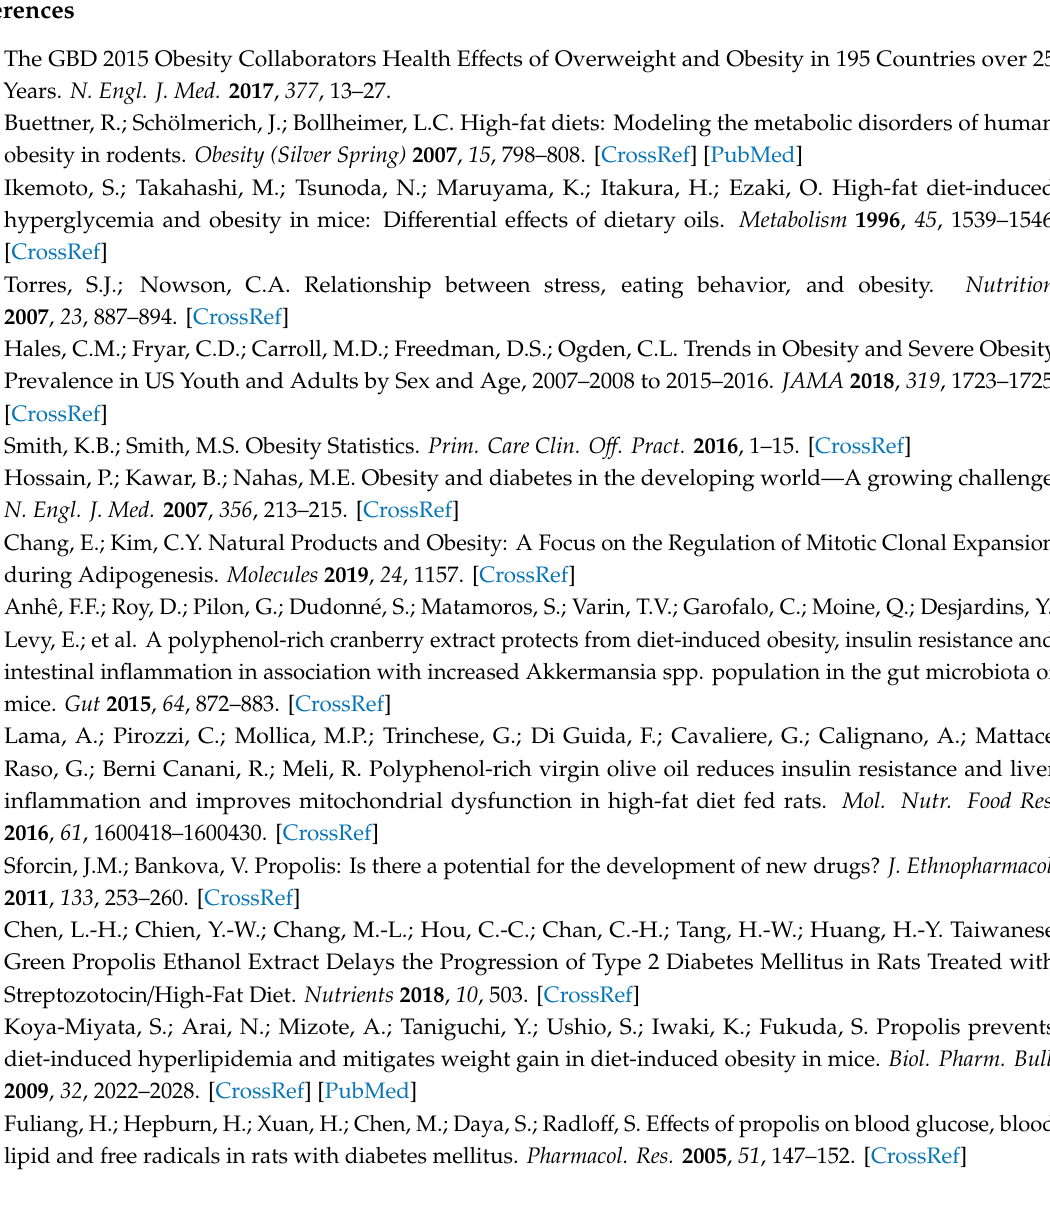
Table S1: The components identified in CP, Table S2: The primers we use in this study, Figure S1: H & E-stained colon